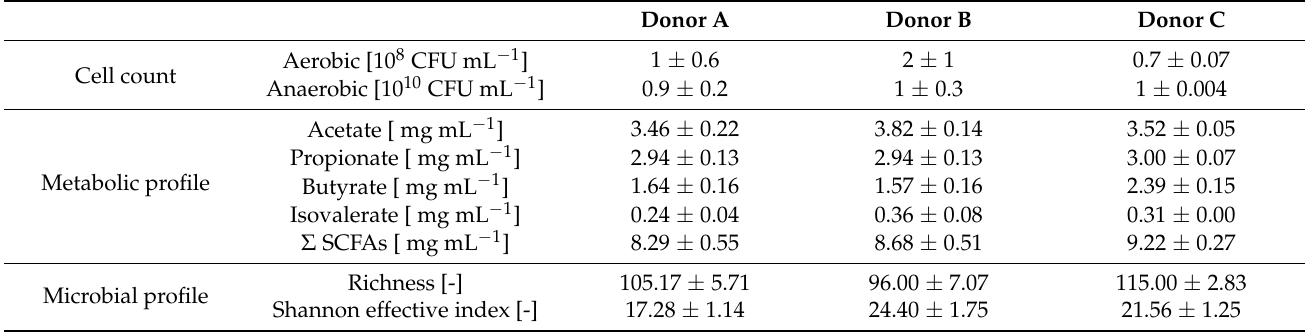
Table 4. Values of cell count, metabolic profile and microbial profile in the stable system (>77 h processing time) for the cultivation of the three donor stools.